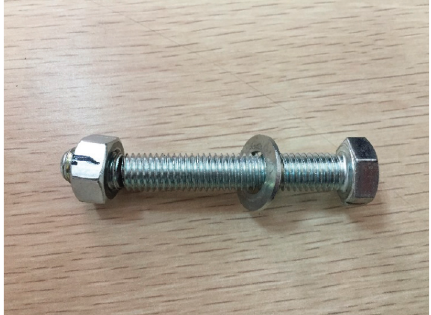
Figure 12: Broken